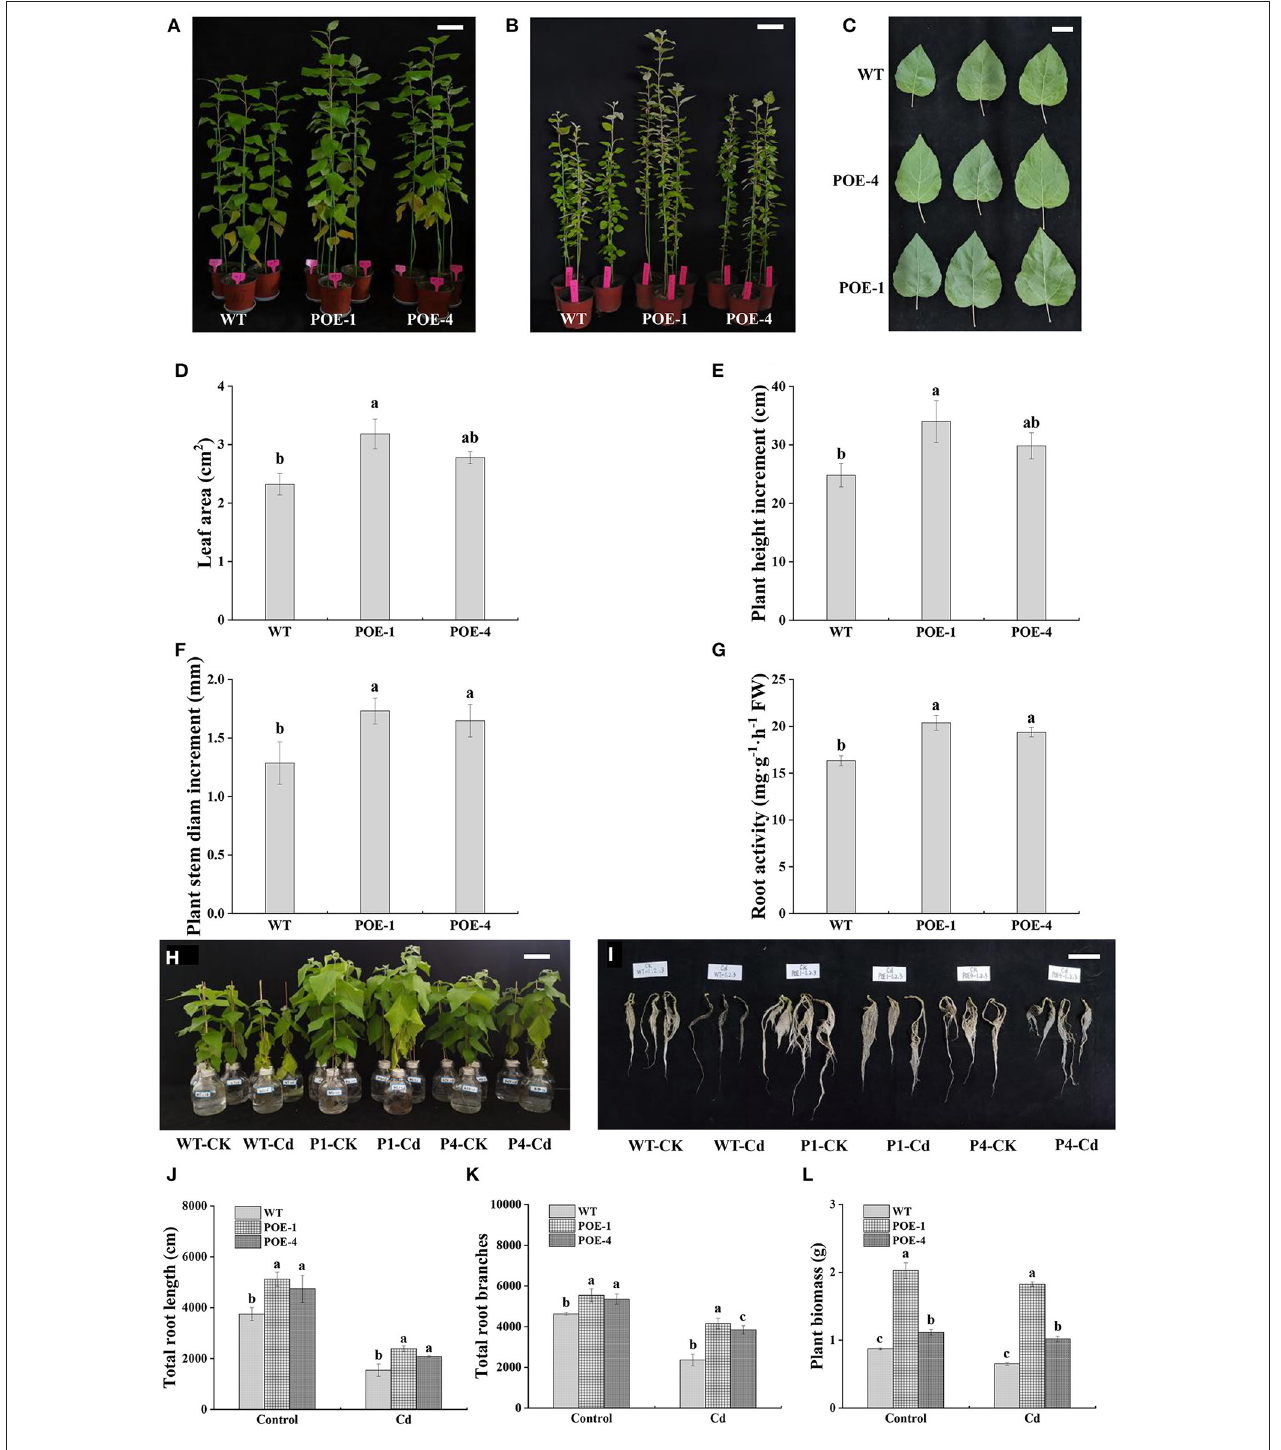
FIGURE 4 | The effects of PscCYP716A1 on poplar growth under cadmium (Cd) stress. (A) The phenotype of WT and transgenic poplars grew in soil with 100 mg · kg − 1 CdCl 2 for 35 days; bar = 10cm. (B) The phenotype of WT and transgenic poplars under control; bar = 15cm. (C) The leaf phenotype of WT and transgenic poplars under Cd stress; bar = 5cm. (D) Leaf area. (E) Height increment. (F) Stem diameter increment. (G) Root activity. (H,I) Phenotypic differences of overground part and root between WT and transgenic lines treated with 0 or 50 µ M CdCl 2 for 21 days; bar = 10cm, P1 and P4: POE-1 and POE-4, CK and Cd symbolize control and Cd treatment, respectively. (J,K) The total root length and root branches. (L) Biomass differences between WT and transgenic poplars. For the same treatment, different letters indicate significant difference ( p < 0.05) between WT and transgenic lines. All of data are shown as the mean ± SD of three biological duplicates.